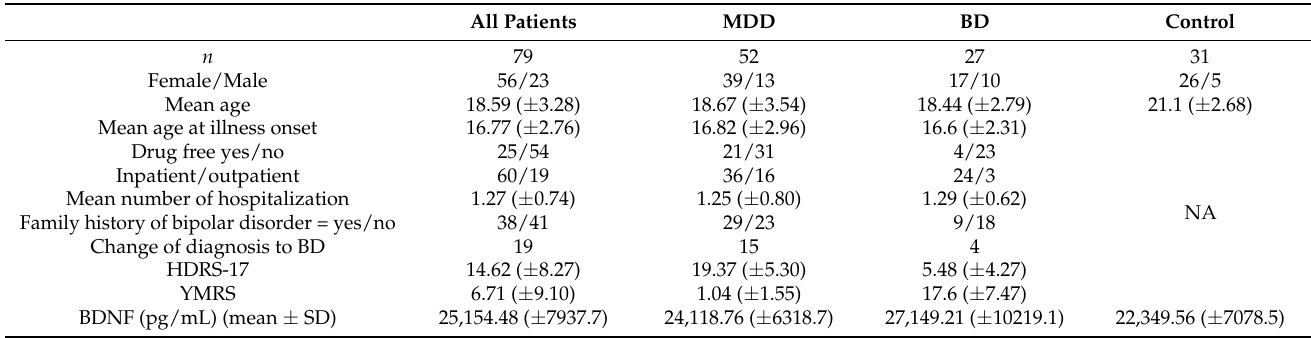
Table 1. Characteristics of the study group at